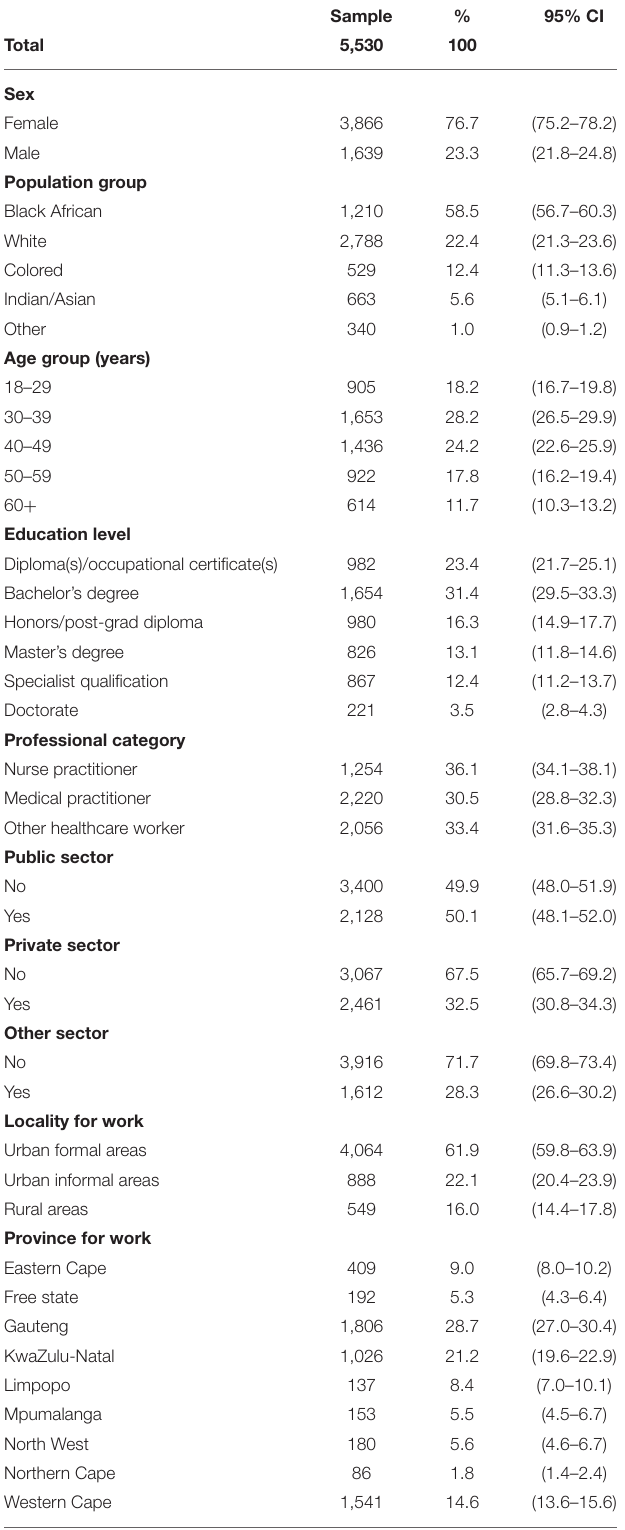
TABLE 1 | Characteristics of the study